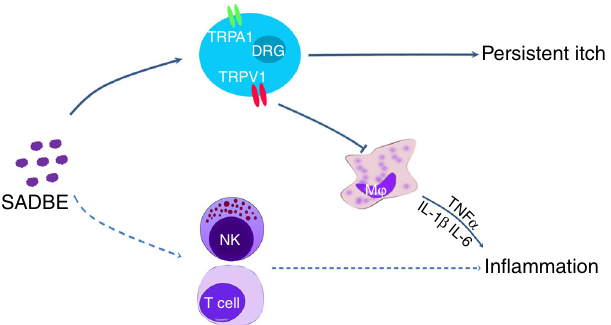
Fig. 8 Working model for SADBE-induced CHS. SADBE could produce persistent itch by directly activating TRPV1-expressing primary sensory neurons that modulates skin in fl ammation through regulating the function of dermal macrophages. Dash lines represent the classic lymphocytes mediated-in fl ammation pathway